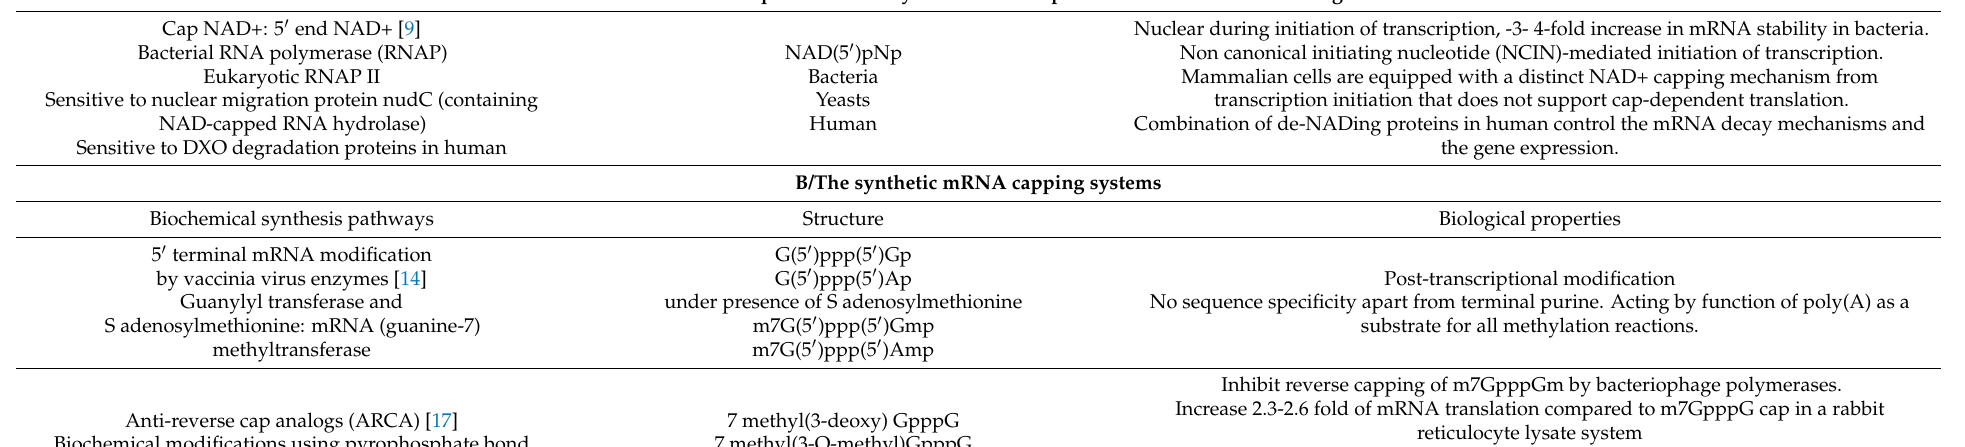
A/The most common natural quanosine methylated mRNA cap modifications and their biological